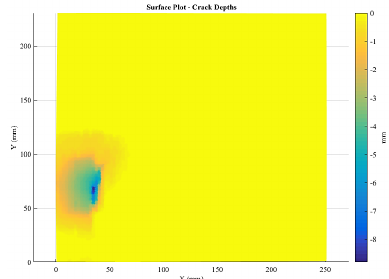
Figure 9. Relative depth of major cracks on surface